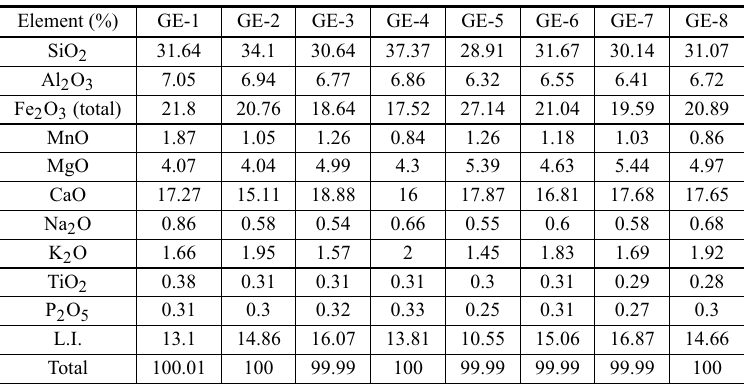
Chemical analysis performed by XRF of eight different soil samples of pathways close to the irrigated land crops. Where L.I. means Lost due to the